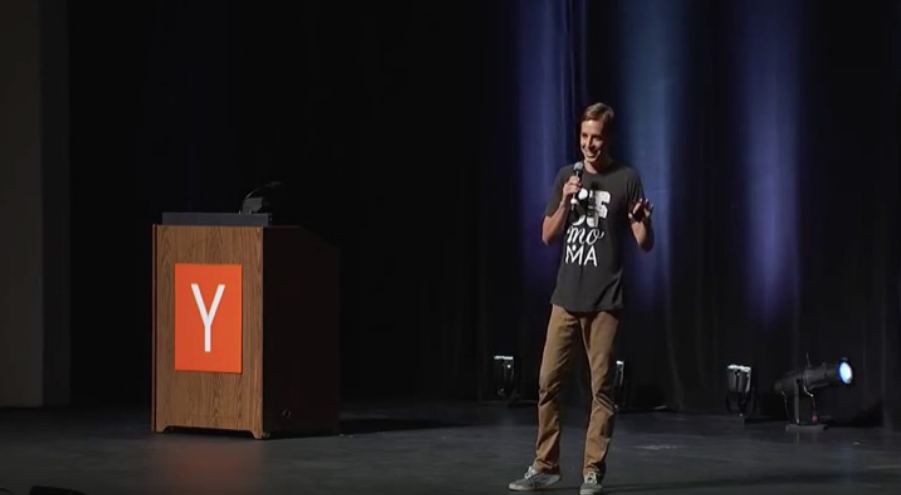
Figure 1. Screenshot of video of Chase Adam’s Y Combinator talk about Watsi’s origins. Source: